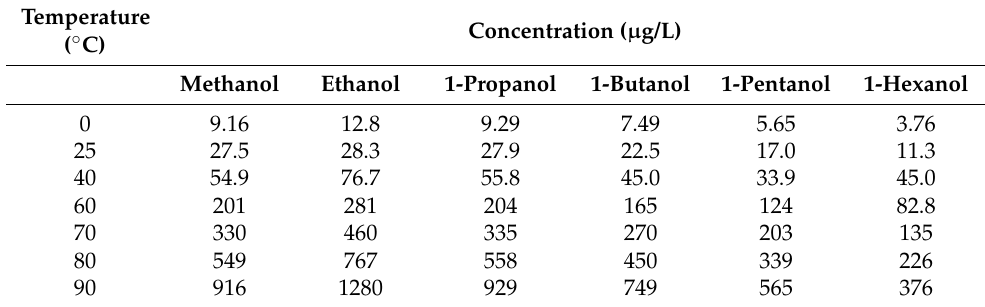
Table 2. 1-Alcohols and their upstream concentrations used in permeation